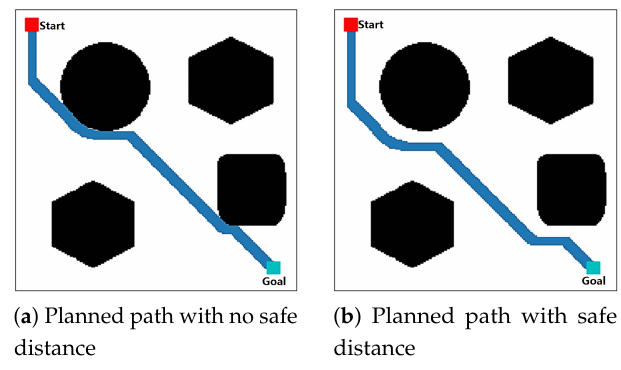
Figure 8. Path planned on 400 × 400